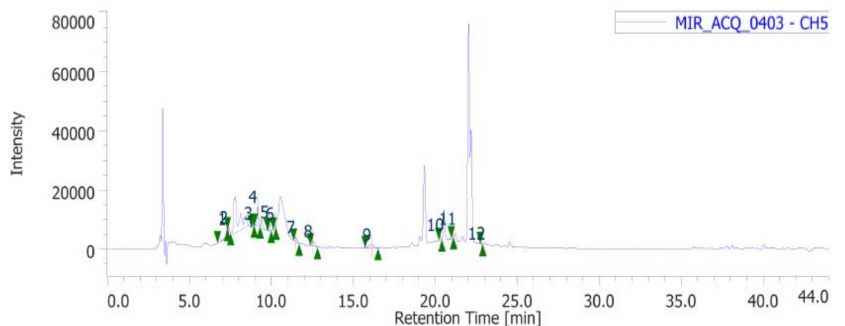
Figure 2. Chromatographic analysis of Prunus mahaleb L. phenolic compounds. The chromatographic analysis confirmed the presence of different phytochemicals, namely gallic acid (peak #2), catechin (peak #5), chlorogenic acid (peak #6), epicatechin (peak #7), caffeic acid (peak #8), chicoric acid (peak #9), coumaric acid (peak #10), ferulic acid (peak #11), and rutin (peak #12).